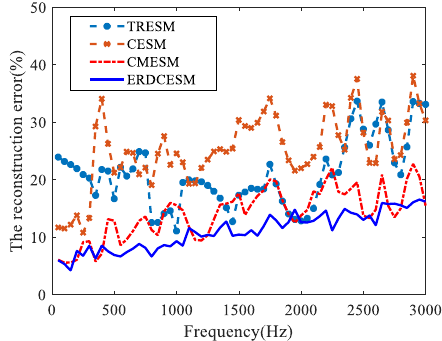
Figure 6. Reconstructed error for a simply supported plate. Frequency interval is 50 Hz.